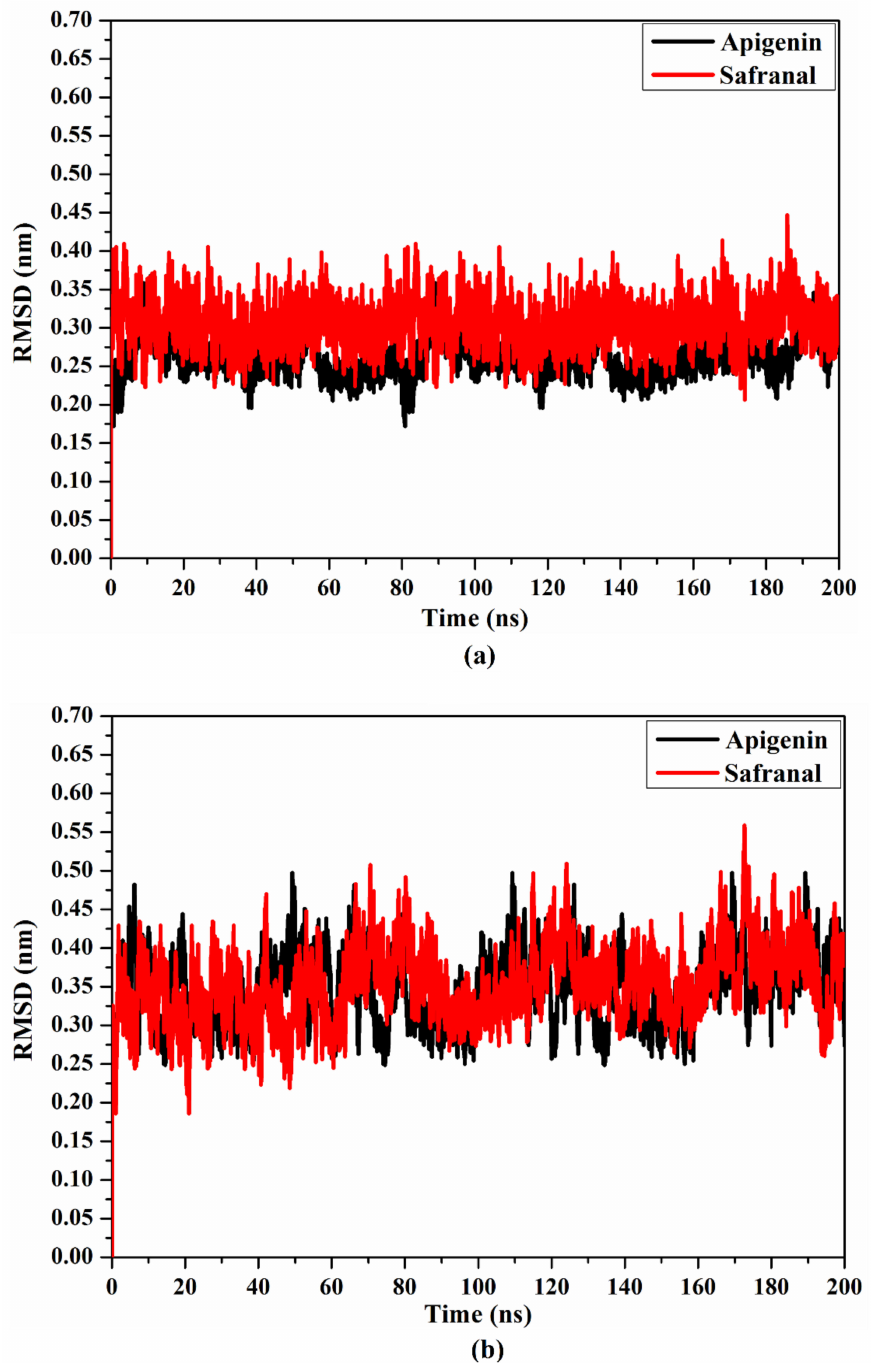
Figure 9. RMSD of apigenin (black) and safranal (red) with the ( a ) 5HT2AR and ( b ) 5HT1AR throughout the 200 ns MD